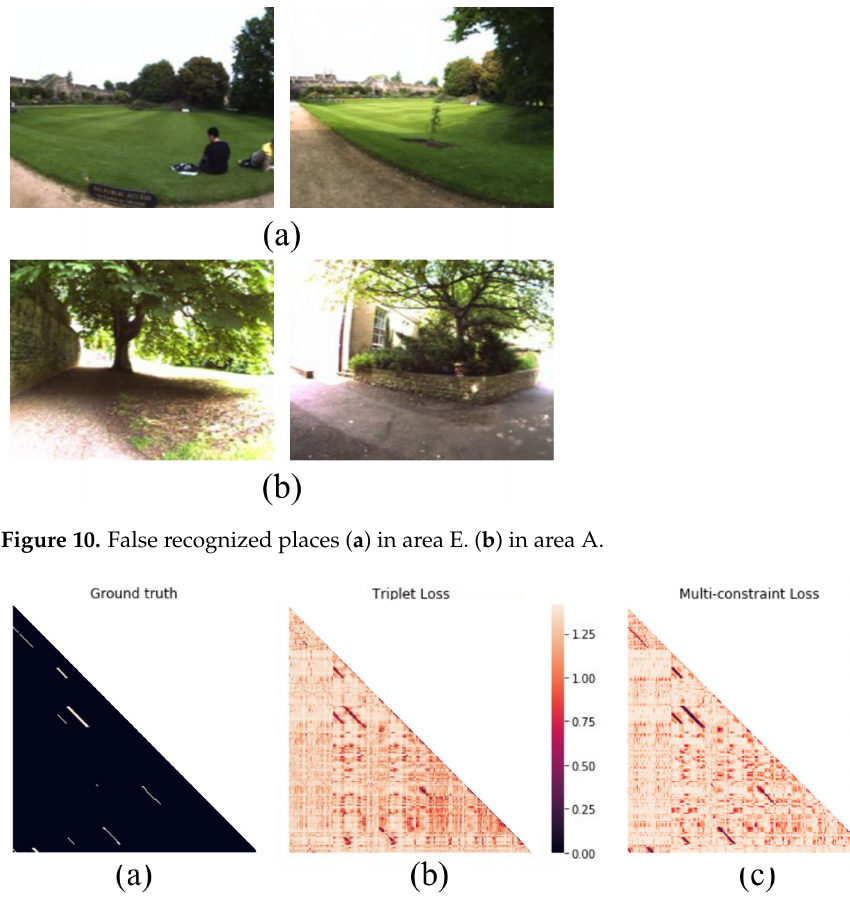
Figure 11. Visualization of the distance matrices. ( a ) The ground truth of the New College dataset. ( b ) The triplet loss. ( c ) The multi-constraint